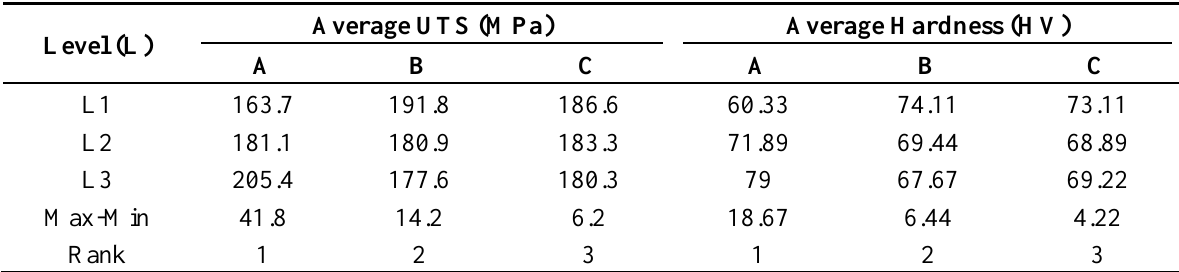
Table 2. Levels average for main